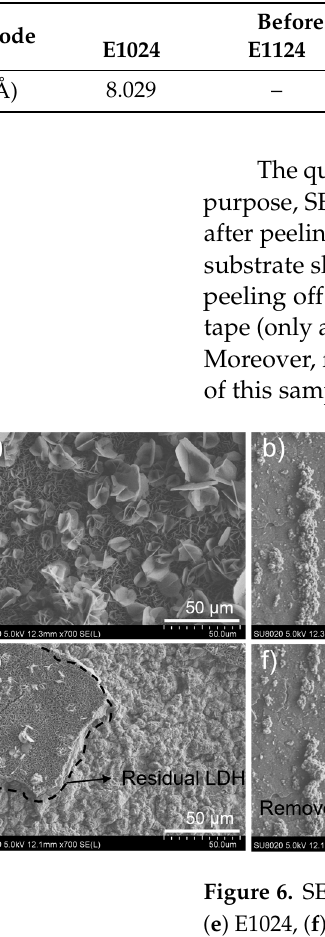
Figure 5. XRD diagrams of ( a ) A1124, ( b ) A1024, ( c ) E1124, and ( d ) E1024, before immersion. Table 4. The d-spacing corresponding to the (003) plane for samples.